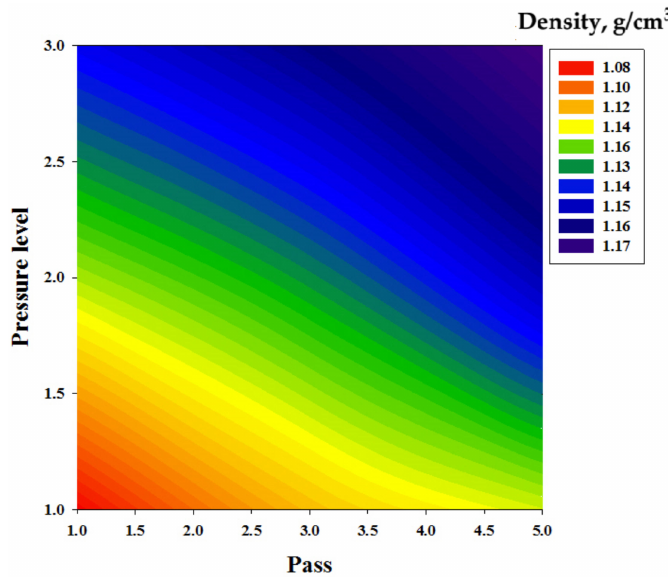
Figure 11. Binary effect tire inflation pressure and traffic on the soil bulk